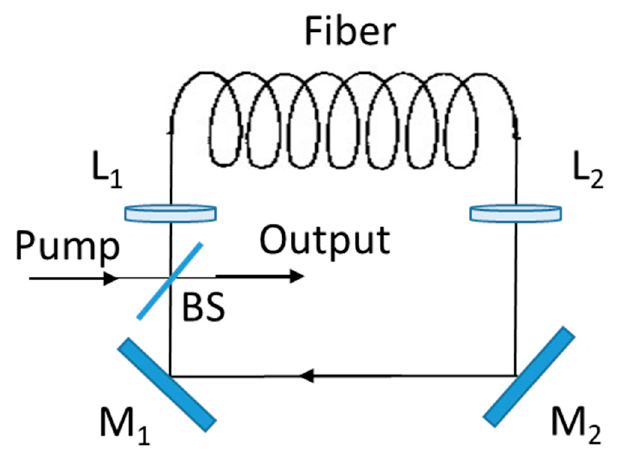
Figure 10. Schematic representation of the ring-cavity geometry implemented for Raman soliton lasers. BS is a dichroic beamsplitter, M 1 and M 2 are mirrors of 100% reflectivity, L 1 and L 2 are microscope objective lenses.